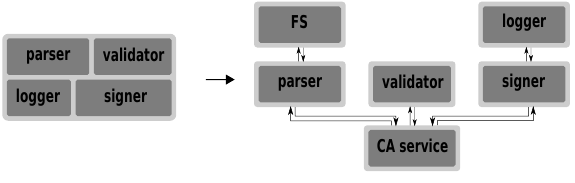
Figure 1. Salus’ compartmentalization enables strong isolation of security-sensitive data and contains possibly vulnerable